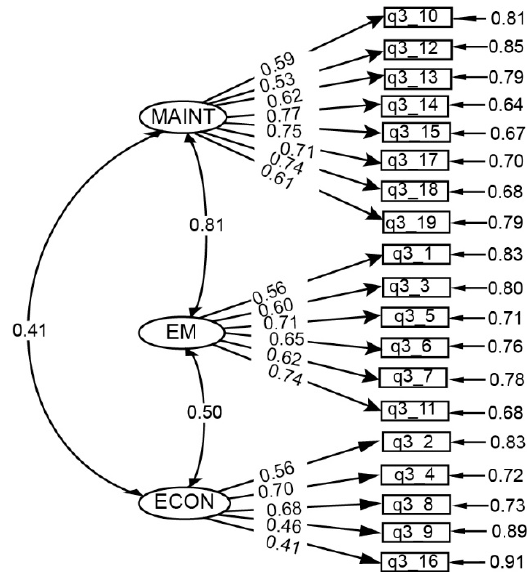
Figure 2. A first-order confirmatory factor analysis of the three-factor structure of forest management. Maintenance forest management (MAINT), ecosystem-centered forest management (EM), and economics-centered management (ECON) correlation. The measured variables and factors are represented with squares and ellipses, respectively. Single-headed arrows indicate the hypothesized causal relationship between two variables; two-headed arrows indicate correlation. Standardized parameters are all significant at p < 0.05.